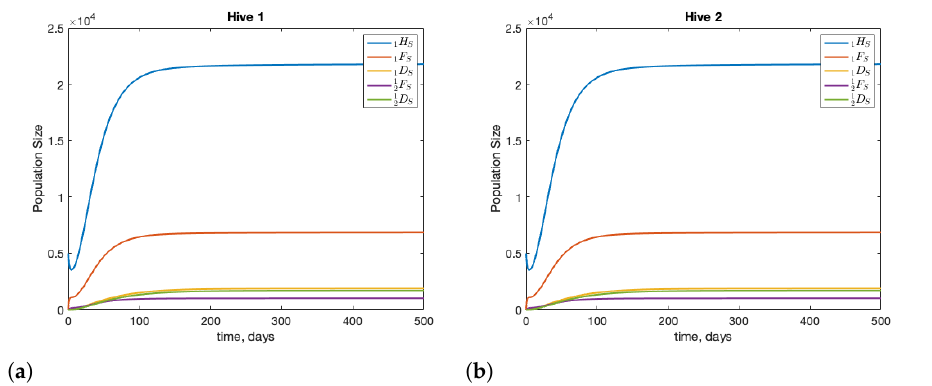
Figure 1. The dynamics of two healthy colonies with interactions through forager and drone drifting for colony 1 ( a ) and colony 2 ( b ). The model is started with initial conditions 1 H S ( 0 ) = 2 H S ( 0 ) = 10,000, and all other compartments with 0 individuals. Food is considered abundant and infinite. As identical parameter sets are used for both colonies, the dynamics of both colonies are the